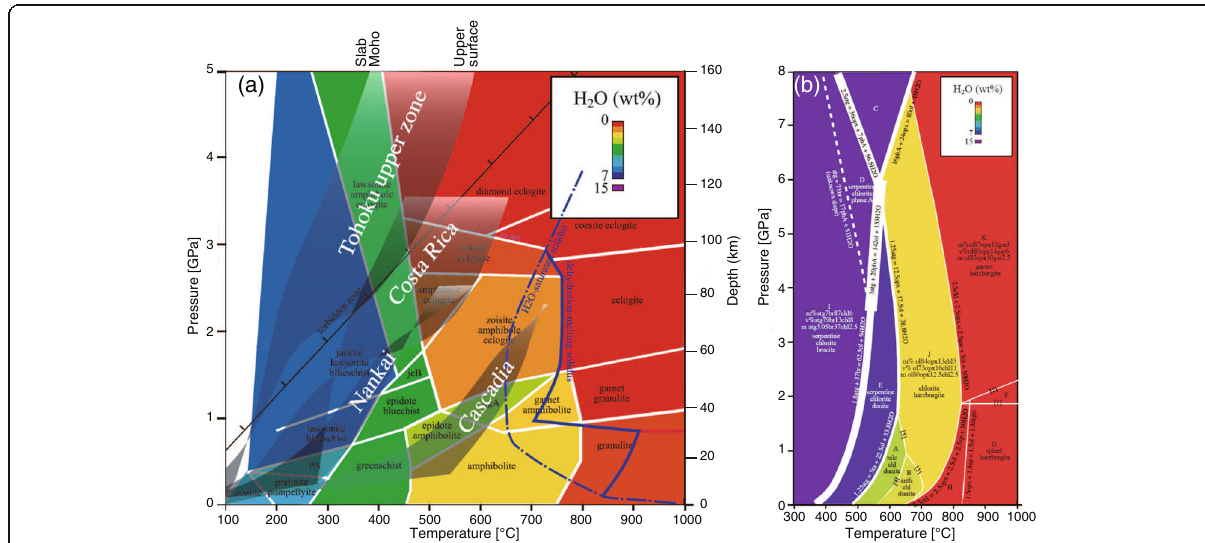
Fig. 3 Metamorphic facies and maximum H 2 O contents. a Mid-ocean ridge basalt (MORB) and b harzburgite. H 2 O contents in wt% are shown by the color scale. Estimated pressure – temperature paths for the slab crust under Tohoku, Costa Rica, Nankai, and Cascadia are indicated as shaded areas in a PA , prehnite – actinolite, eA epidote amphibolite, eB epidote blueschist, and jeB jadeite – epidote blueschist. (After Hacker et al. 2003b)